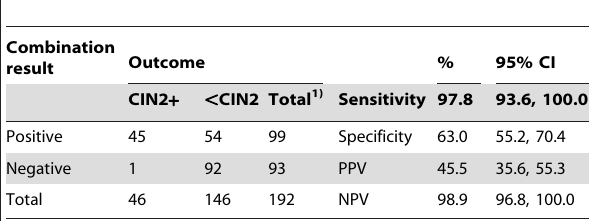
Table 5. Outcome for the 192 women in the HPV group if triaged by post-colposcopy HPV mRNA combined with cytology when cut-off is ASC-US + .